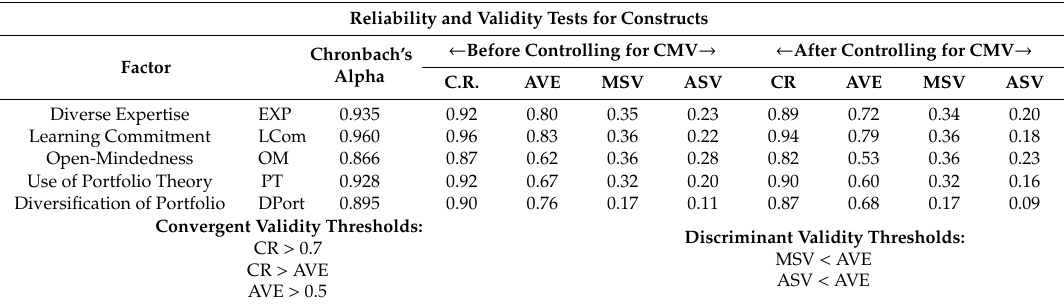
Table 4. Reliability and Validity Tests for